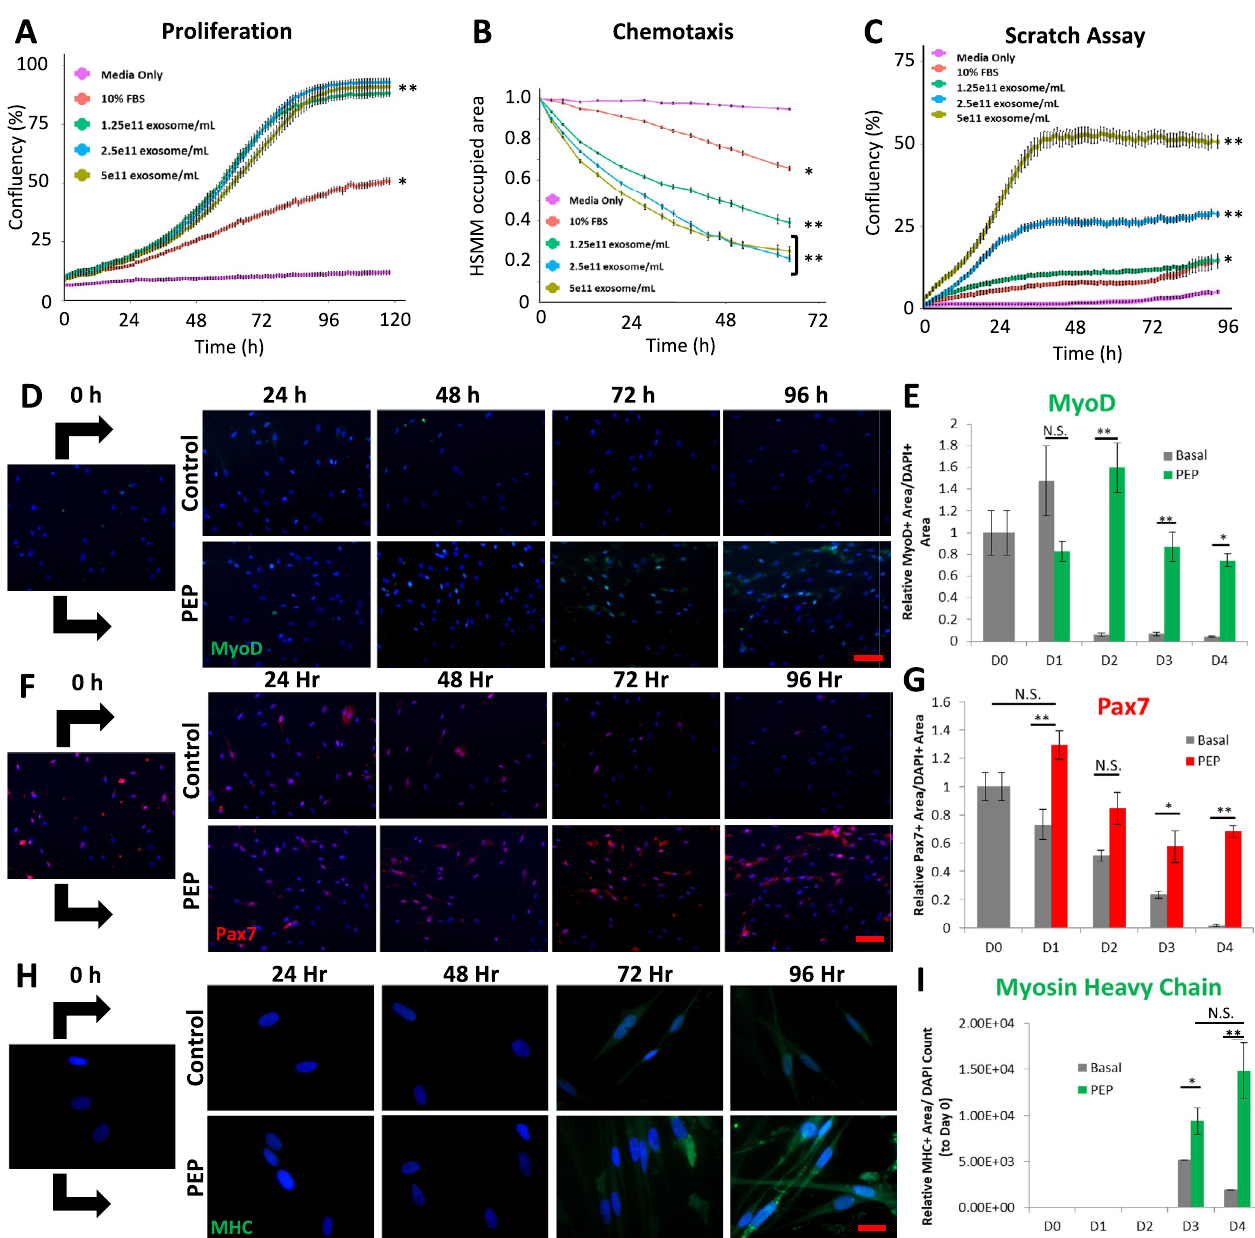
Fig. 2 Puri fi ed exosome product functional characterization and in vitro human skeletal muscle myoblasts (HSMM) culturing with increasing concentration of PEP. A IncuCyte proliferation, B chemotaxis, and C wound scratch analyses of HSMM grown with increasing concentration of PEP ranging from 1.25 × 10 11 exosomes/mL to 5 × 10 11 exosomes/mL and media supplemented with 10% fetal bovine serum (FBS) versus serum-free media. D – I Representative immunocytochemistry of a 96 h time-course of HSMM cultured with serum-free media (Control) or serum-free media plus 2.5 × 10 11 exosomes/mL PEP (PEP). Immunostaining for MyoD ( D ; green, scale = 100 µm), Pax7 ( F ; red, scale = 100 µm), and Myosin Heavy Chain (MHC, H ; green, scale = 20 µm). Nuclei counterstained with DAPI (blue). ImageJ blind quanti fi cation of E MyoD + Area/DAPI + Area, G Pax7 + Area/DAPI + Area, and I Myosin Heavy Chain + Area/DAPI object count, relative to day zero. N.S. Not signi fi cant; * p < 0.05; ** p < 0.005. Data represents AVE ± SEM. Student ’ s t -test was